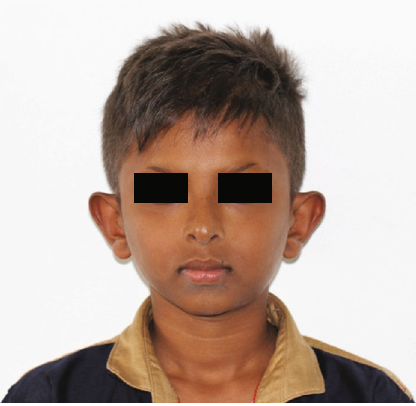
Figure 2: Facial image of the